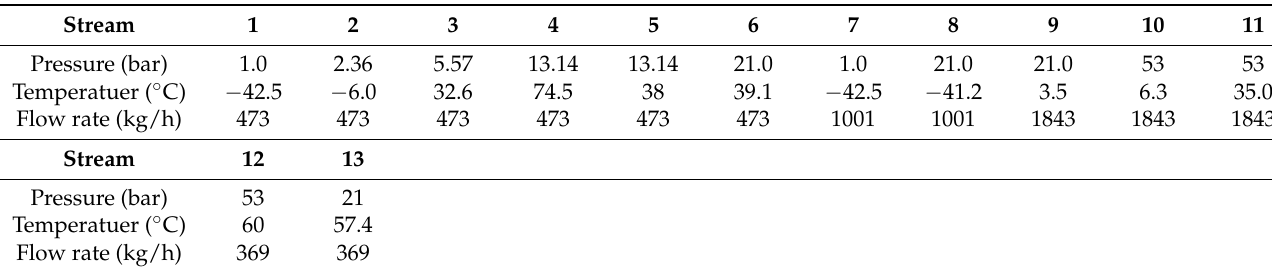
Figure 4. Process flow diagram (PFD) of the conventional re-liquefaction and fuel supply systems. The process flow diagram (PFD) and stream information of the novel re-liquefaction system with FSS are shown in Figure 5 and Table 4. The BOG produced from the cargo tanks is entered into the re-liquefaction system. The entered BOG is compressed by three stages of compressor. The compressed BOG by first and second stage compressors can be cooled by seawater depending on its temperature. The entirely compressed BOG by the third stage compressor is condensed by seawater at the condenser. The condensed BOG is supplied to the FSS after pressurizing to the discharge pressure of the LP pump. The condensed BOG from the re-liquefaction system is combined (mixed) with the stream from fuel tanks, and then they are sent to the HP pump. The stream pressurized by the HP pump is supplied to the engine after passing the heat exchanger, filter, and FVT. When the engine load is low and the amount of condensed BOG is greater than the amount required by the engine, the condensed BOG is stored in the pump suction drum. If the pump suction drum is full, the condensed BOG is expanded by the J-T valve. After the expansion, the stream is sent to the separator. The liquefied stream in the separator is transferred to the cargo tank, and the remaining stream (vapor) is recirculated into the stage one compressor. Table 4. Stream information of the novel re-liquefaction system with